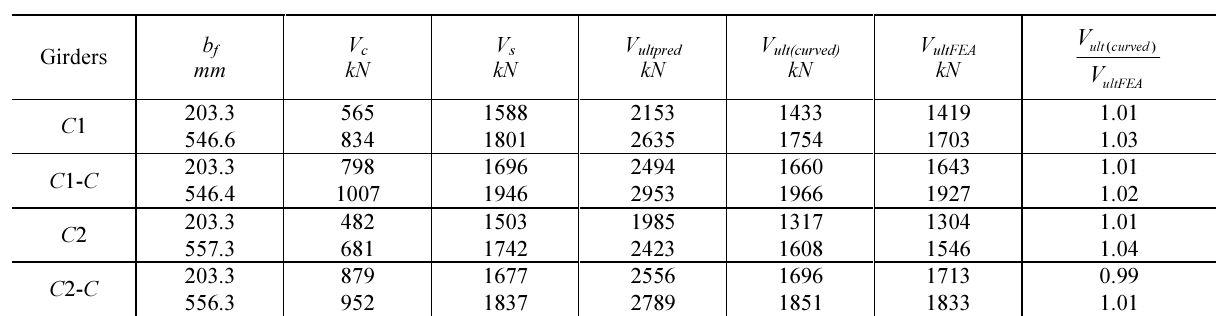
Table 1. Comparison of results for girders with solid webs